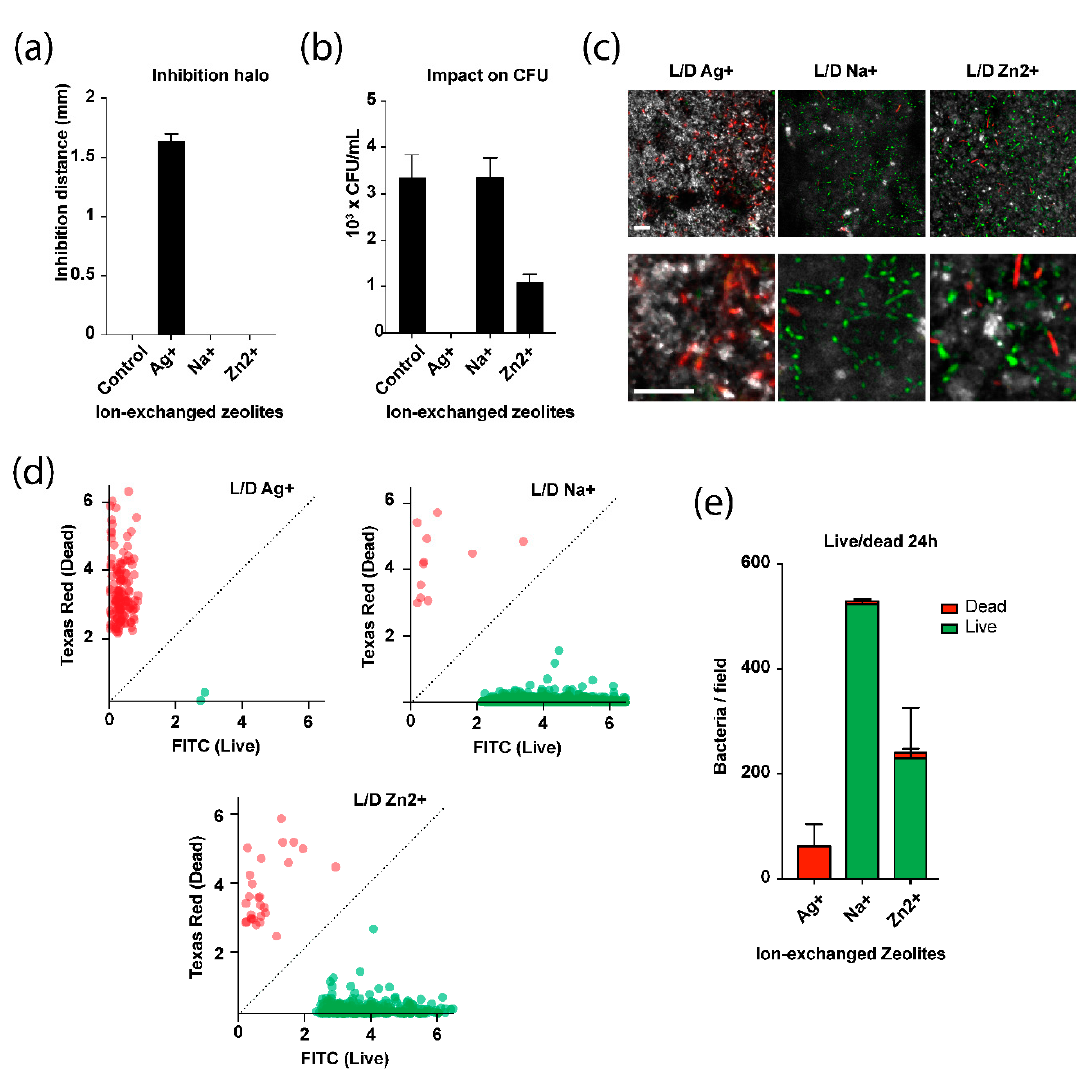
Figure 7. Antimicrobial activity of ion-exchanged zeolites. ( a ) Inhibition distances of E. coli bacteria growth by Na-FAU zeolite membrane and ion-exchanged (Ag + and Zn 2 + ) zeolite membranes measured by agarose di ff usion assay. ( b ) Antibacterial activity of the zeolites measured by CFU counts on agar plates. ( c ) Fluorescence microscope images of E. coli cells on the surface of ion-exchanged zeolites after live / dead staining (syto9 in green, propidium iodide in red, scale presented on the image correspond to 10 µ m). The surface is observed using laser reflection (gray levels). ( d ) Quantification of the overall live populations (green) compared to dead populations (red). ( e ) Integration of the data presented in ( d ) showing the live / dead ratio and the total amount of bacteria on the zeolite